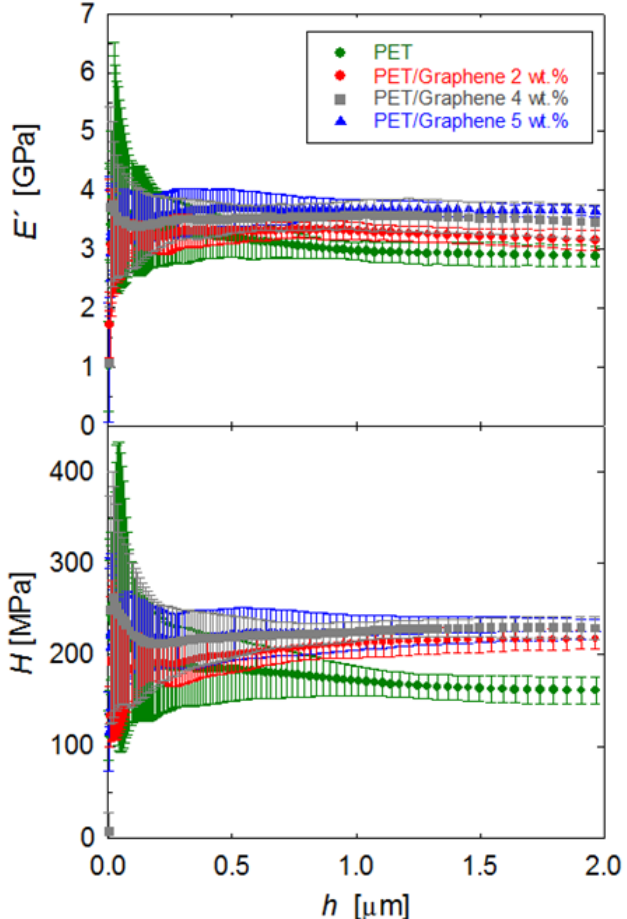
Figure 9. E´ and H behavior as a function of indent displacement, for PET and PET/graphene fibers.